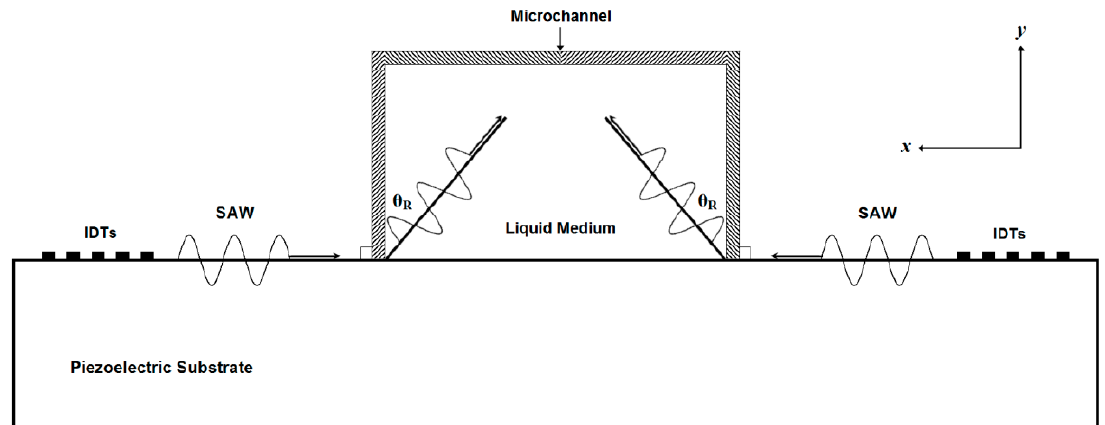
Figure 2. The configuration of Rayleigh angle ( θ R ) affect on the propagation of SAW.